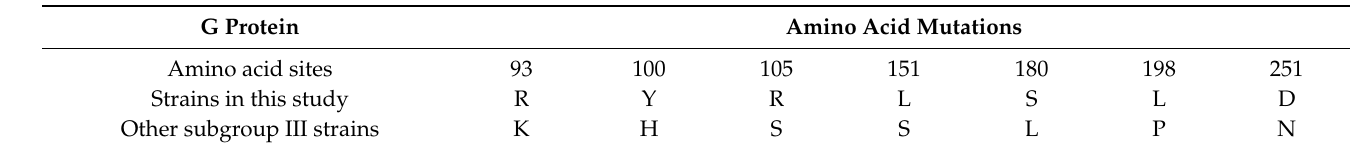
Table 3. Unique Amino acid mutations of G protein sequences in this study compared with all subgroup III strains in GenBank.